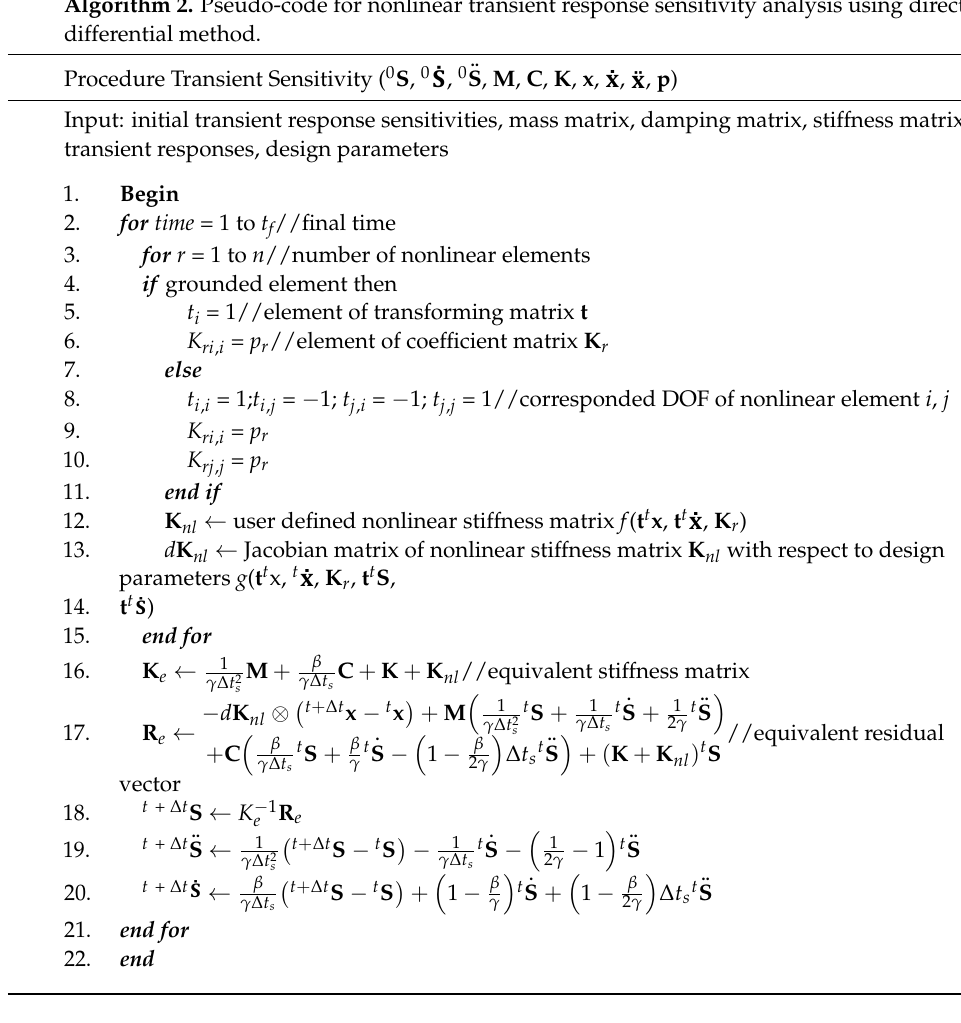
Algorithm 1. Pseudo-code for initial transient response sensitivity